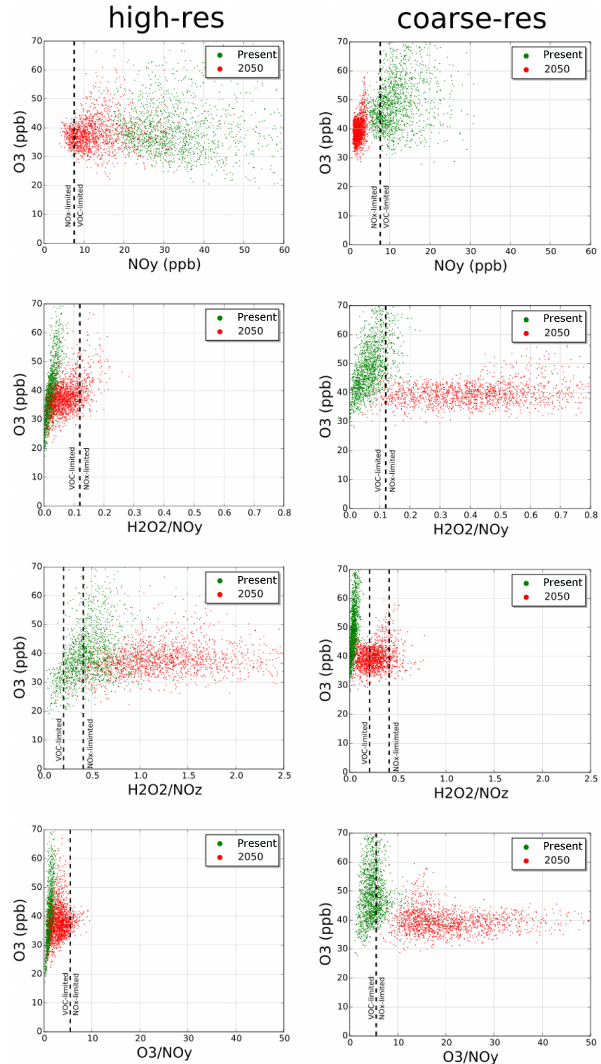
Figure 6. Scatter plots of daily average ozone concentrations ( y axis) against chemical regime indicators ( x axis) for the present and future runs in Paris. Results are presented for the high- resolution (left panels) and the coarse-resolution (right panels) ap- plications. Dots correspond to daily average concentrations for each day of the ozone period. For each indicator the limit value that sep- arates the regimes is also depicted with a dashed